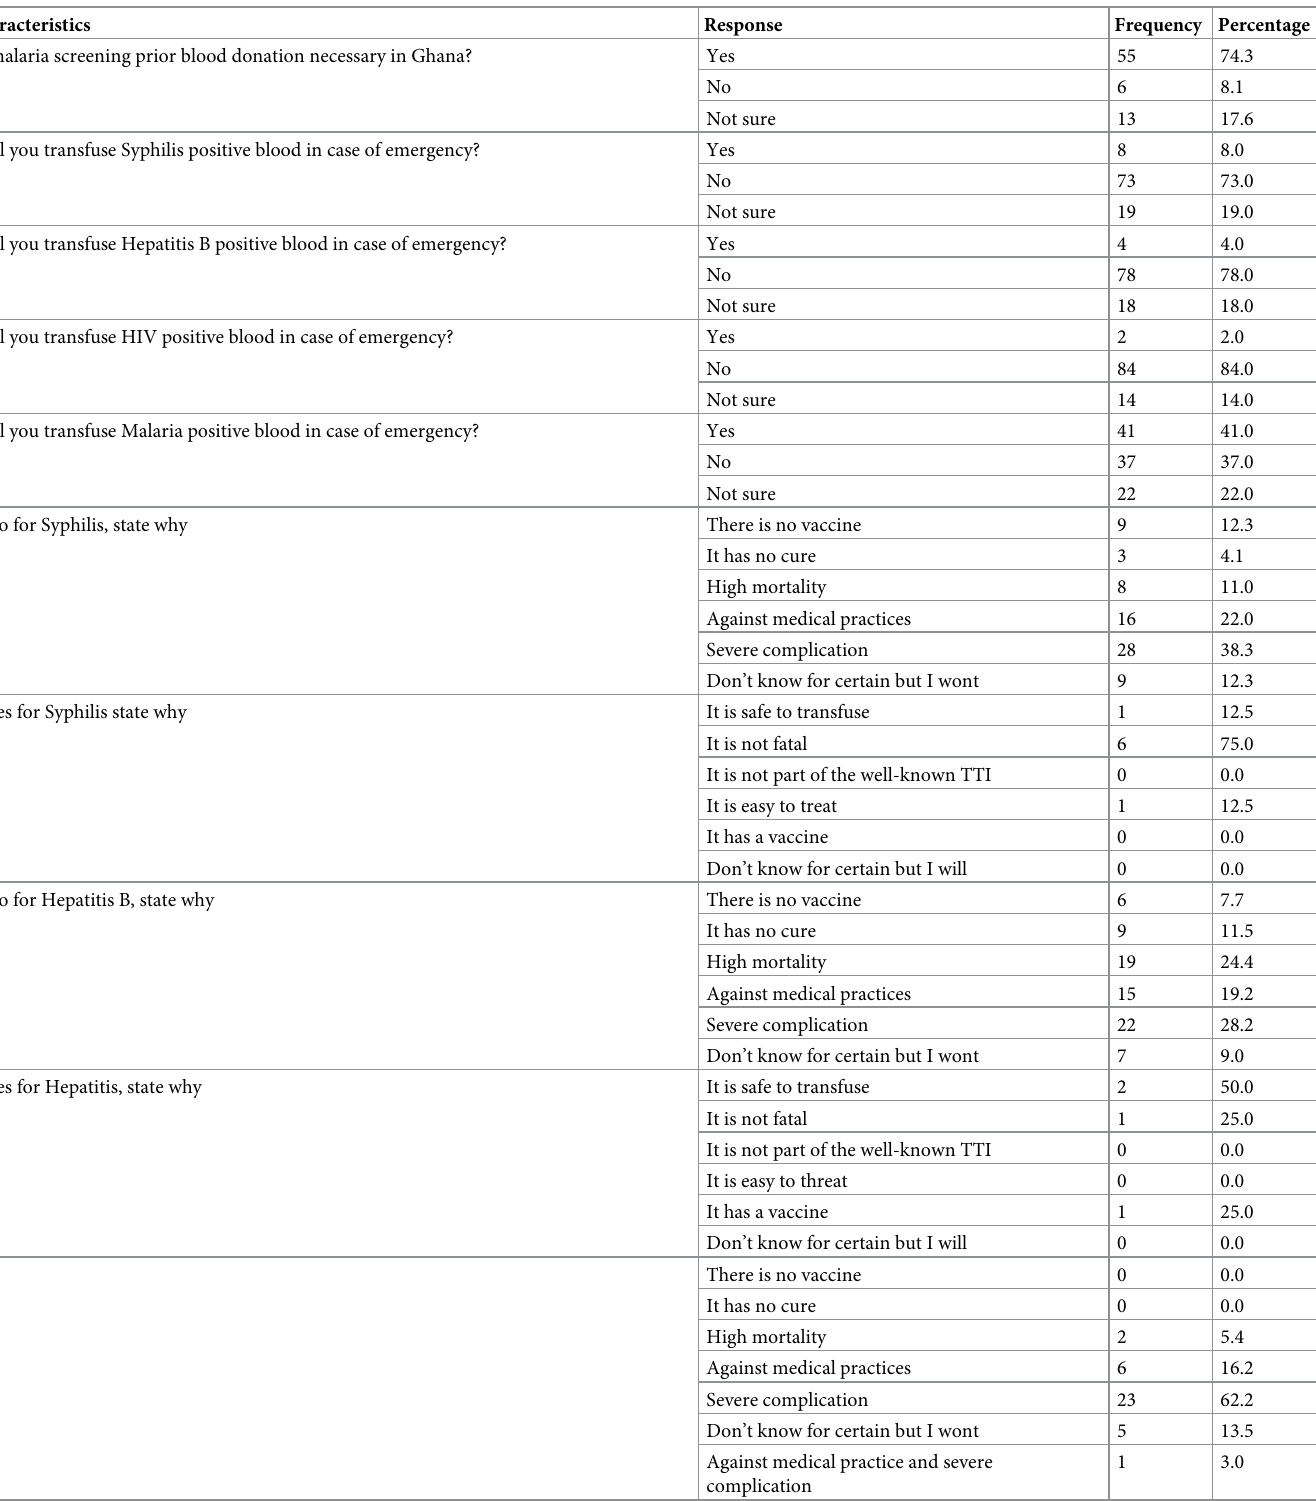
Table 5. Attitude and practices of health workers towards